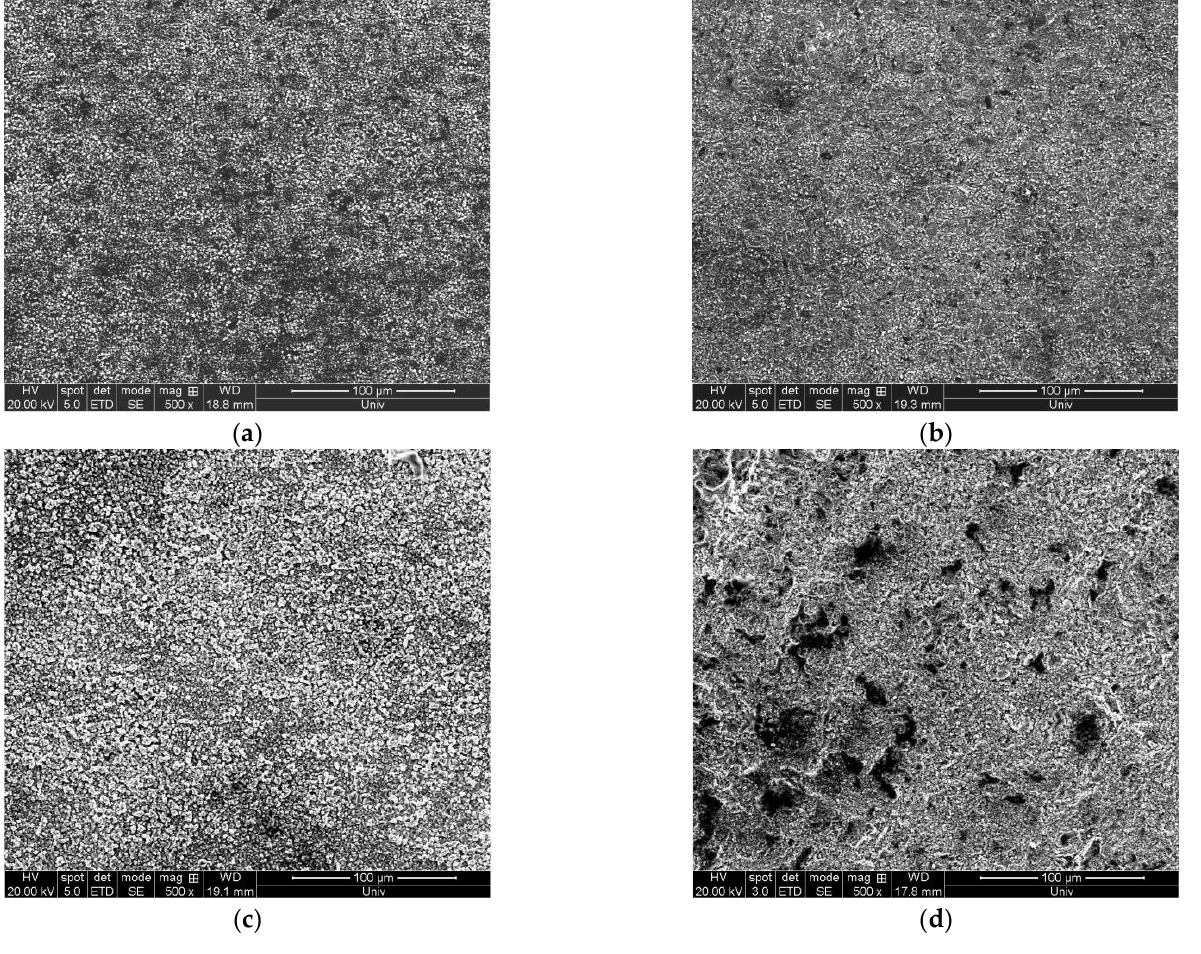
Figure 13. Surface morphology of vanadium deposition layer on a cathode plate at different times: ( a ) 10 min, ( b ) 20 min, ( c ) 30 min, and ( d ) 50 min. ( a ) 10 min, ( b ) 20 min, ( c ) 30 min, and ( d ) 50